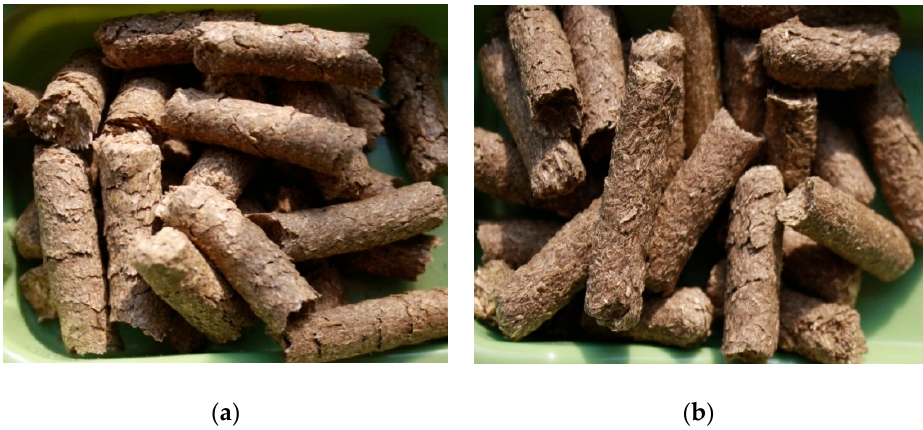
Figure 1. Pellets made of rape straw—( a ) Multi-component fertilizer (NPK) fertilization; ( b ) NPK fertilization + glycerol 10%.